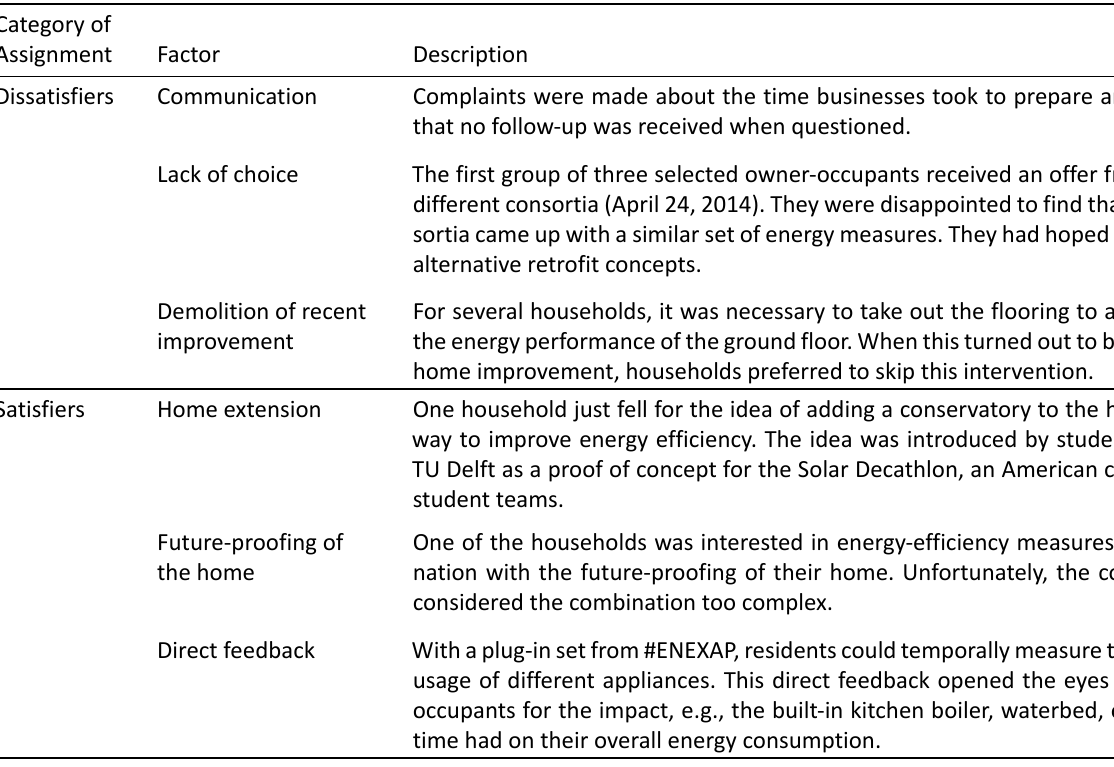
Table 2. Dissatisfiers, satisfiers, criticals, and neutrals in the perception of owner‐occupants involved in #ENEXAP. Category of Assignment